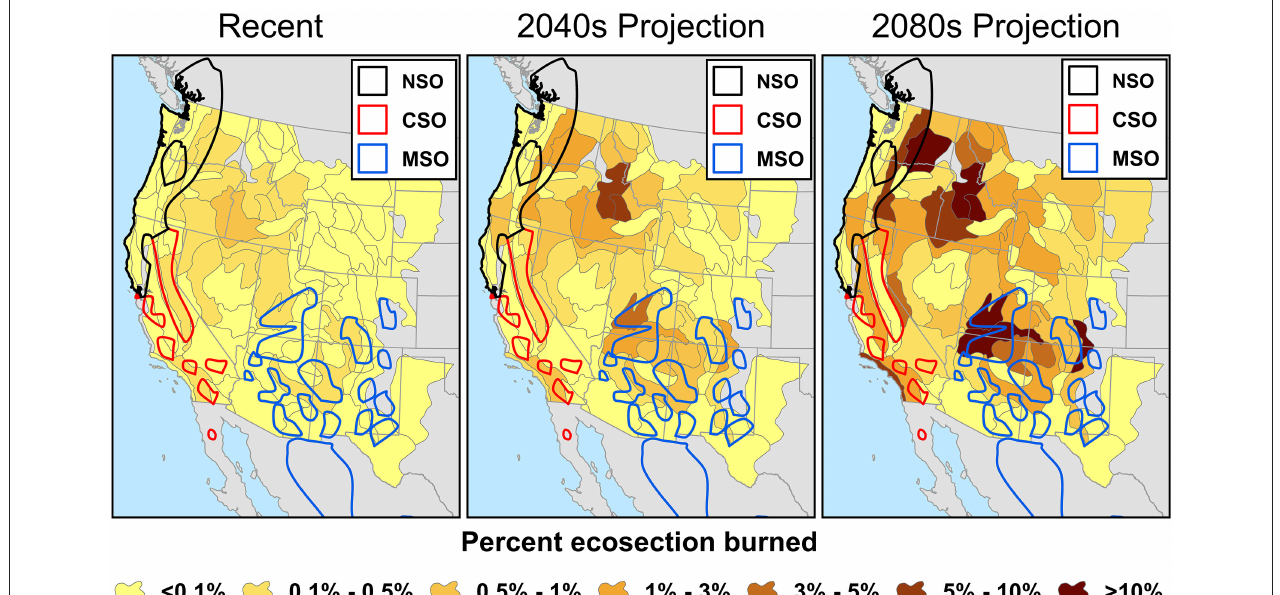
FIGURE 3 | Increasing trends in percent area burned across the western United States by Bailey’s ecosections (Bailey, 1995) based on predictions from non-stationary climate-fire models by Littell et al. (2018). Ranges of the northern spotted owl (NSO), California spotted owl (CSO), and Mexican spotted owl (MSO) are indicated by black, red, and blue polygons respectively. Area in gray indicates data were unavailable.